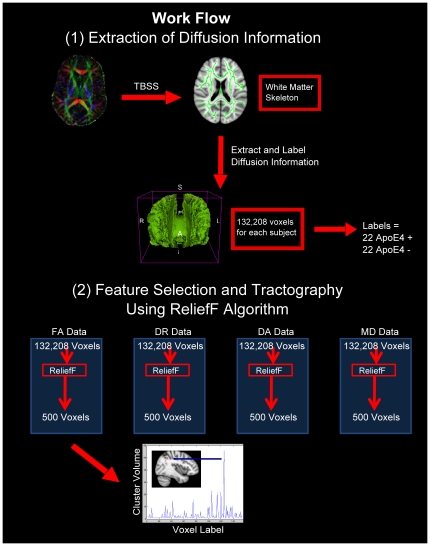
Workflow for the processing of white matter diffusion information.(1) Following TBSS processing a white matter skeleton is created which is common to all subjects. Diffusion values are then extracted from every voxel in the white matter skeleton using a custom made matlab script. Data is then labelled as either ApoE4 carrier or non-carrier. (2) Following preparation of the data into a WEKA compatible format the data is reduced using a feature selection algorithm, ReliefF. This algorithm selects the most salient voxels for group classification. These voxels are then used for training a support vector machine (SVM) classifier and subsequently the classification is performed with this classifier. The lowermost figure shows a readout of top 500 voxels selected from the full FA dataset. The y-axis represents the volume of particular clusters and the location of the largest cluster is shown circled in white in the anatomical images.